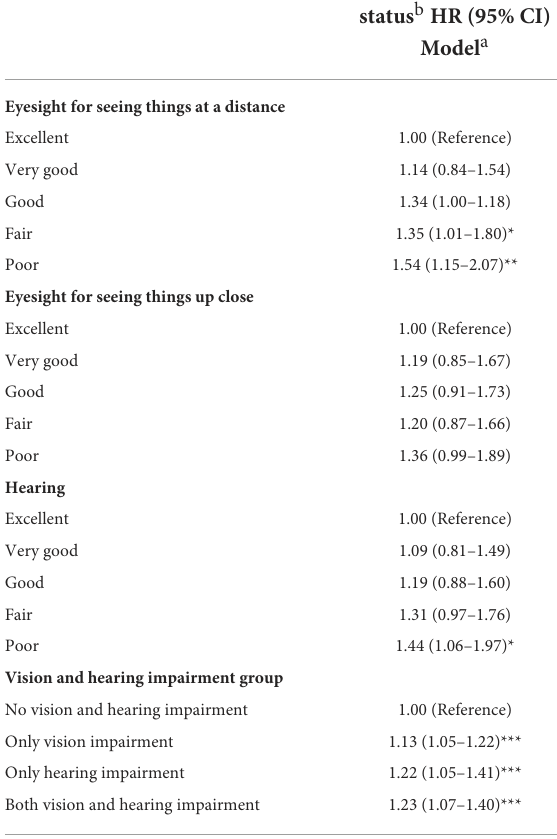
TABLE 4 Association of vision and hearing status with depressive symptoms by the Fine and Gray competing risk analysis. Vision and hearing